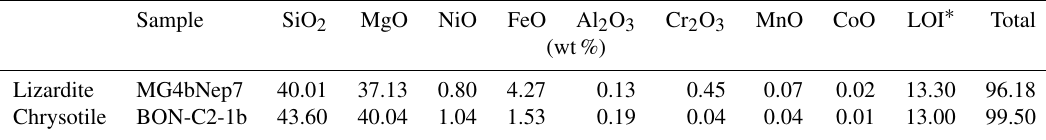
Table 1. Chemical composition of the serpentine group mineral samples